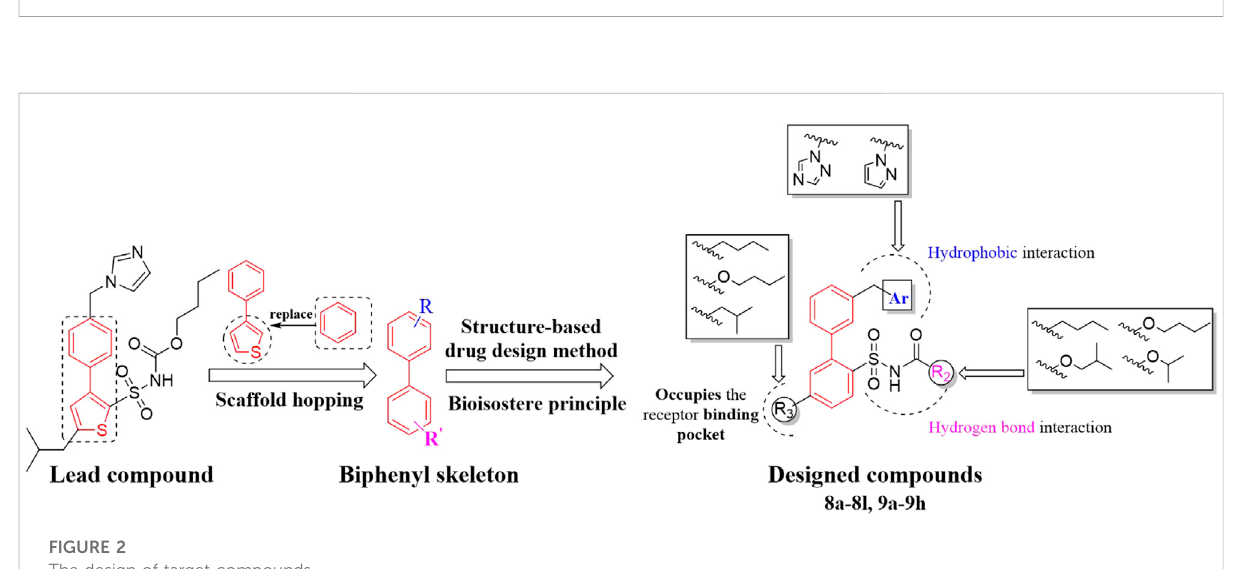
FIGURE 1 Small changes in the structure of the compound lead to the change of functional activity.